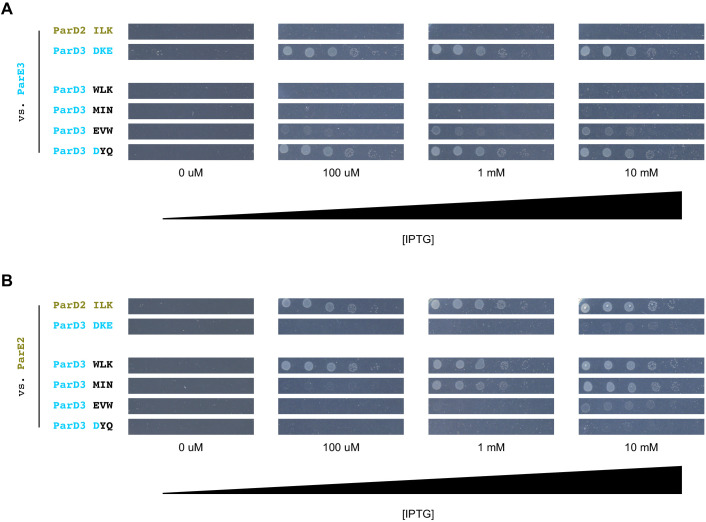
Comparing the relative fitness of variants across different induction levels.(A) Cell growth of strains expressing ParE3 and indicated ParD3 variants in the presence of different concentrations of IPTG. Variants correspond to those in Figure 2—figure supplement 1E. (B) Same as (A), but for ParE2.